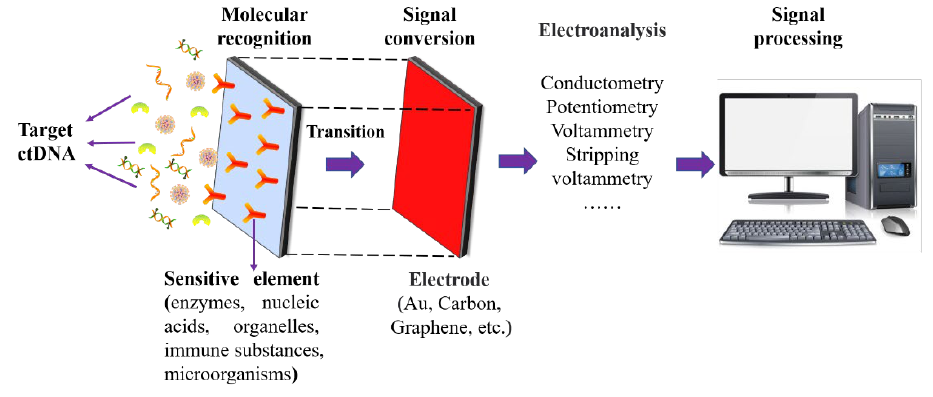
Figure 1. Schematic diagram of ctDNA electrochemical biosensor detection system.